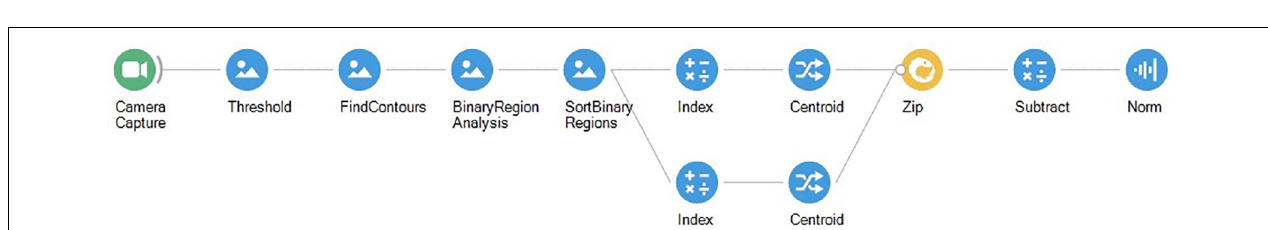
FIGURE 11 | Closed-loop patch-clamp experiment with Bonsai (contributed by Gonçalo Lopes, André Marques-Smith, Luis Jacinto, and Patricia Monteiro [unpublished]).